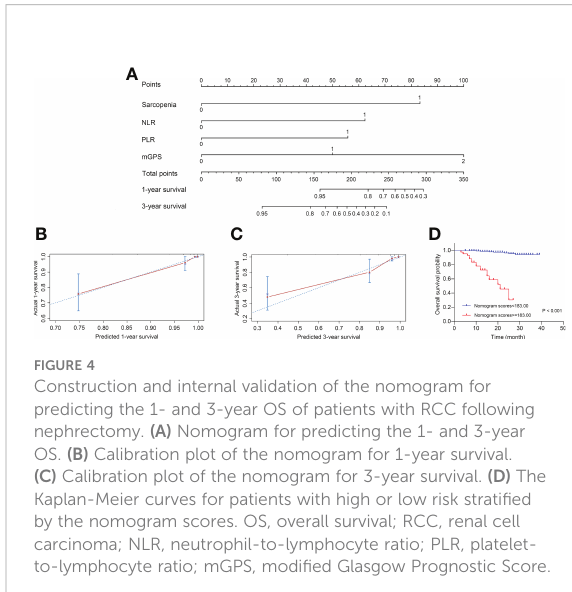
FIGURE 4 Construction and internal validation of the nomogram for predicting the 1- and 3-year OS of patients with RCC following nephrectomy. (A) Nomogram for predicting the 1- and 3-year OS. (B) Calibration plot of the nomogram for 1-year survival. (C) Calibration plot of the nomogram for 3-year survival. (D) The Kaplan-Meier curves for patients with high or low risk strati fi ed by the nomogram scores. OS, overall survival; RCC, renal cell carcinoma; NLR, neutrophil-to-lymphocyte ratio; PLR, platelet- to-lymphocyte ratio; mGPS, modi fi ed Glasgow Prognostic